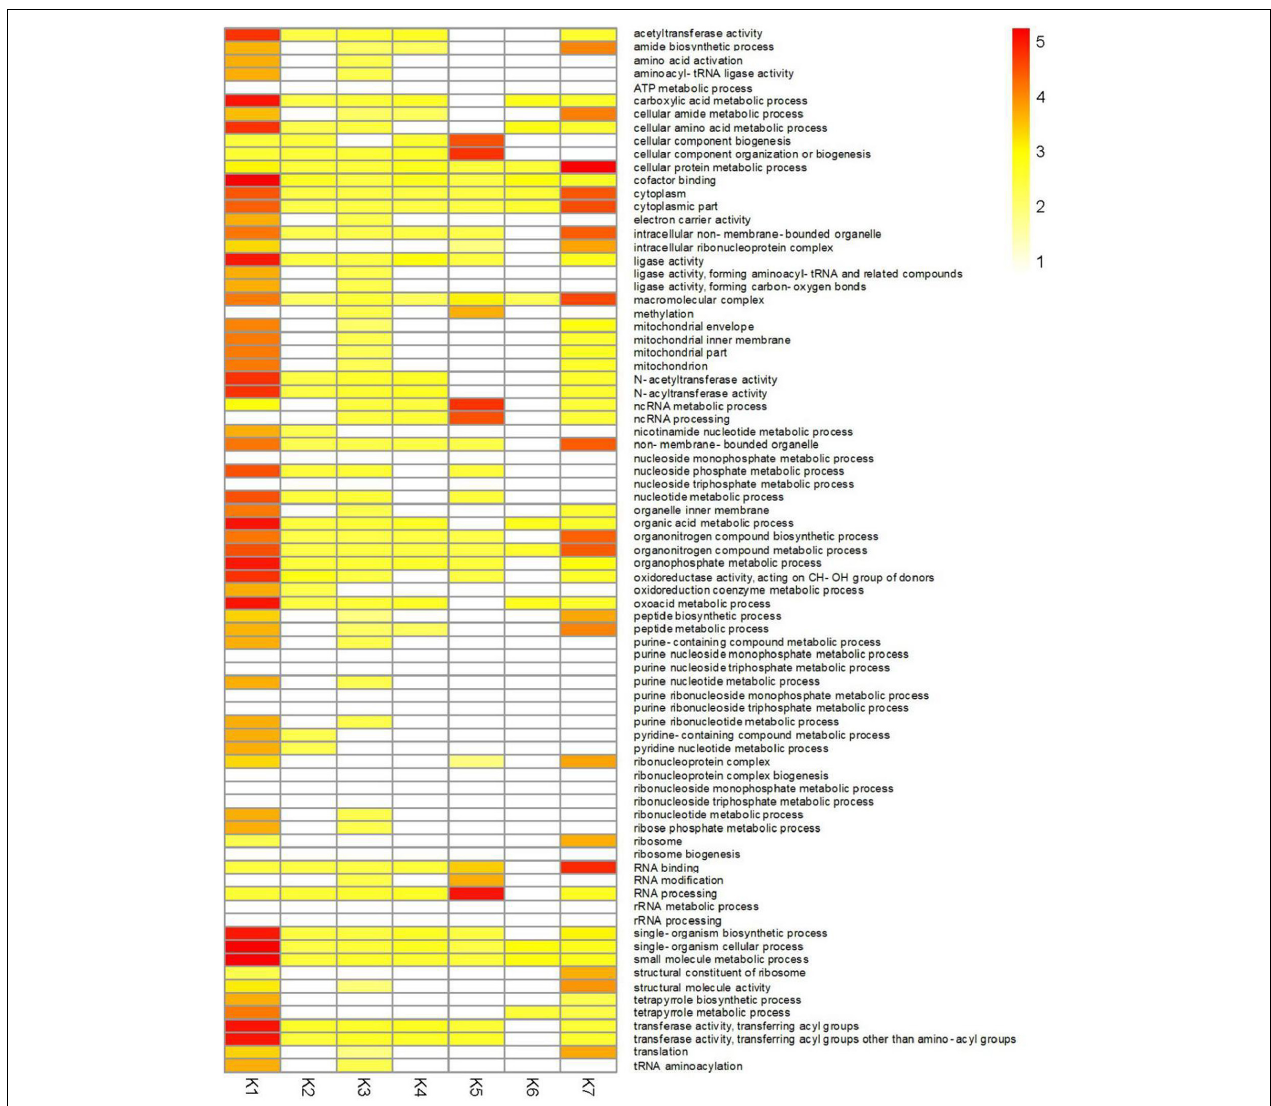
FIGURE 6 | GO enrichment analysis of DEGs in different clusters of CF in T. virens GV29-8. Gene Ontology enrichment among the 7 clusters. Yellow to red: significant enrichment ( P < 0.05). White,